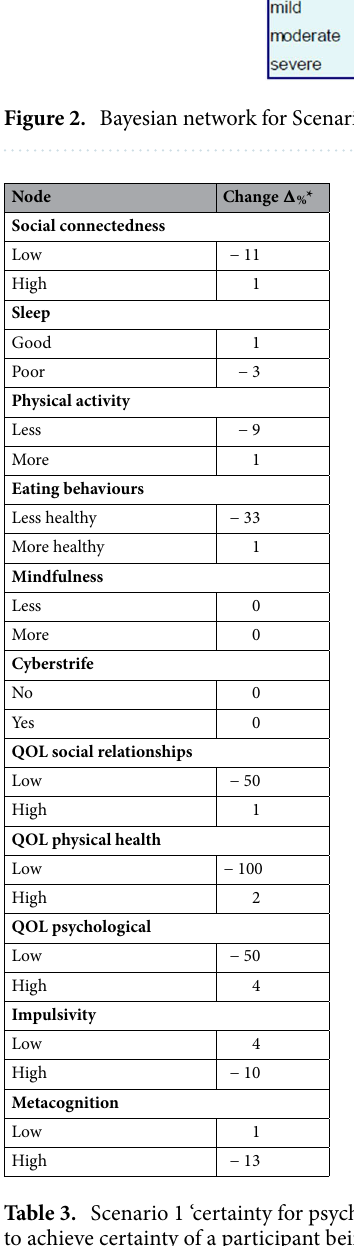
P evidence − P baseline P baseline ×